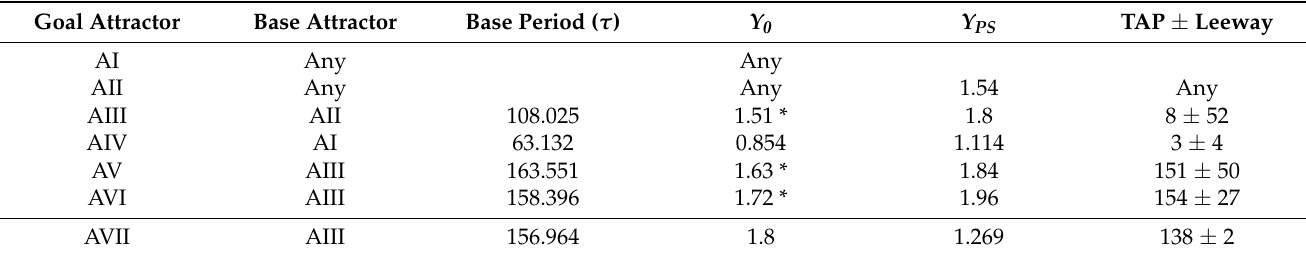
Table A1. LIS Attractor Access Via a Power Shift Y PS